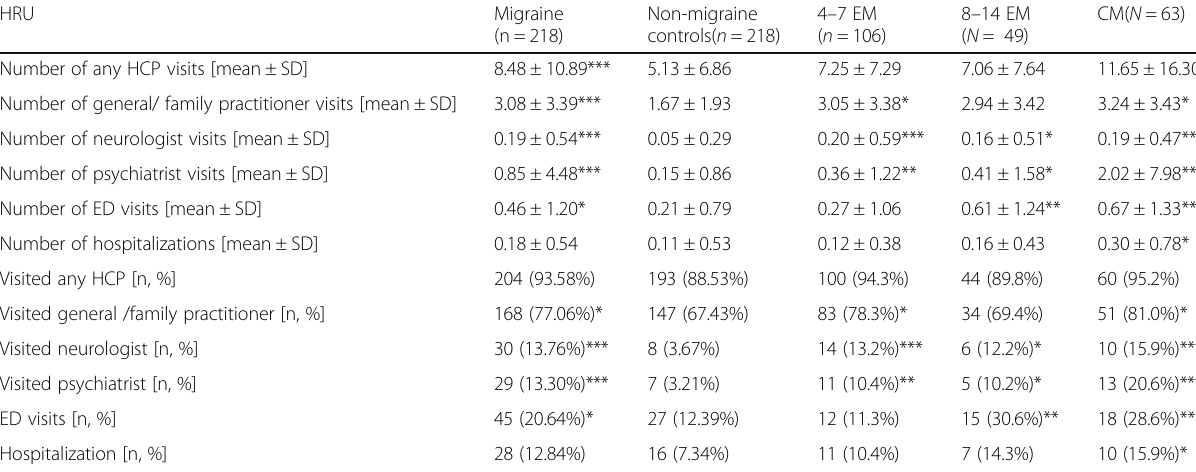
Table 2 Healthcare resource utilization in the past 6 months among people with migraine and its subgroups vs propensity score matched non-migraine controls across EU5